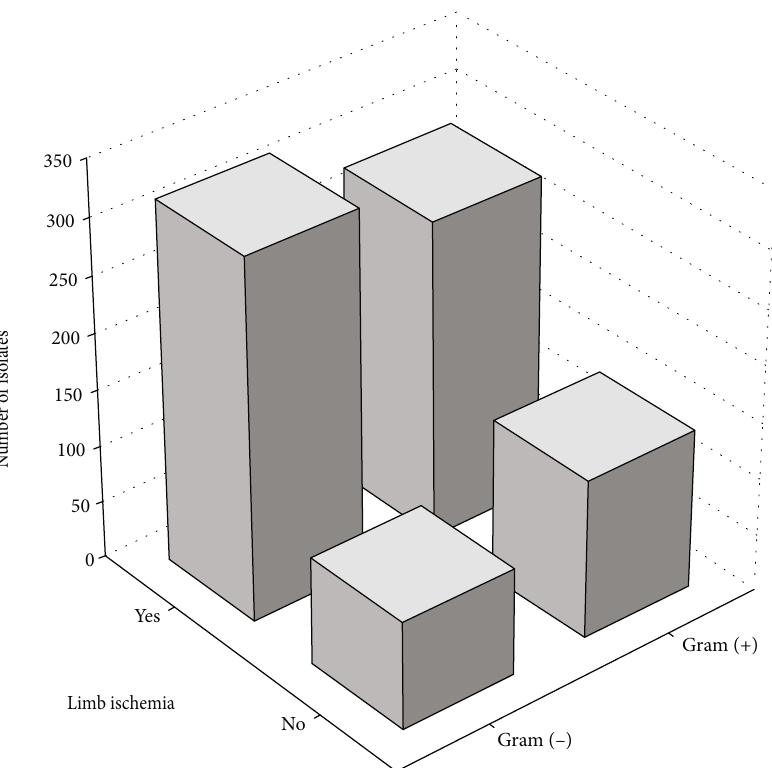
Figure 1: The proportion of Gram-positive and Gram-negative bacteria in patients with and without coexistent peripheral arterial disease (extremity